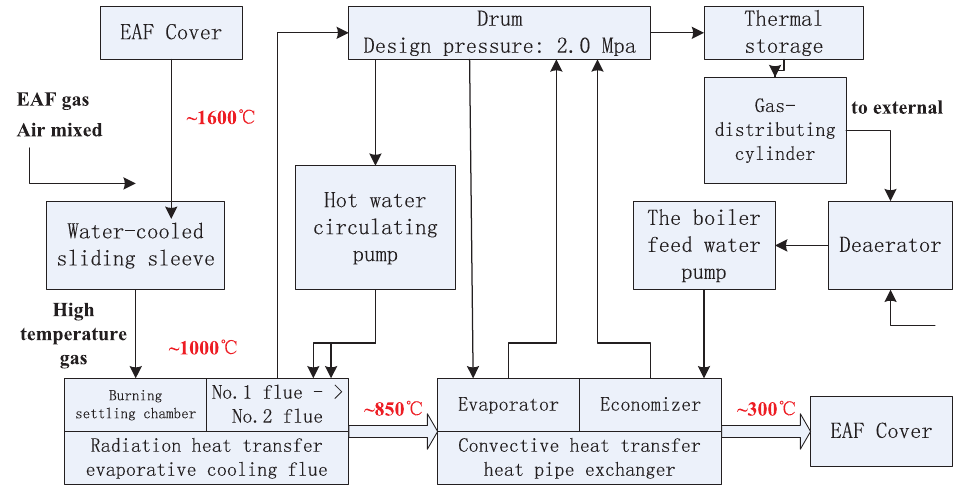
Figure 1: Xingcheng special steel EAF gas waste heat utilization system.